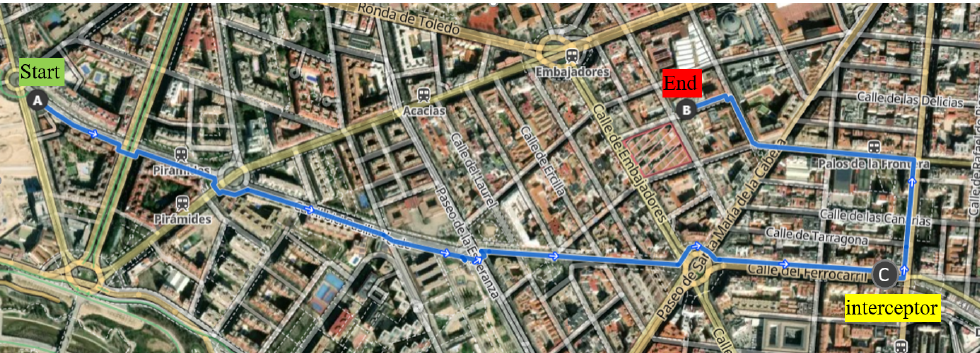
Figure 1. Experimental route in Madrid.